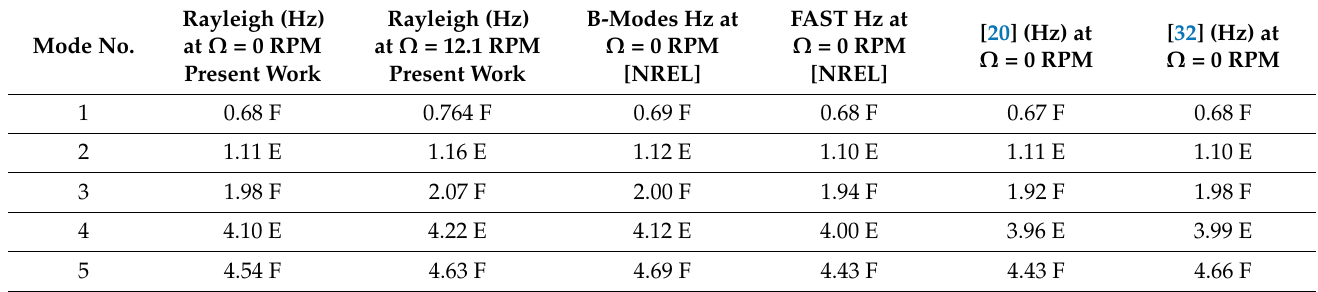
Table 4. Natural frequencies in the flap-wise and edge-wise directions of a single blade without aerodynamic force at angular speed Ω = 12.1 RPM for the present study and Ω = 0 RPM for the present study and for the data adapted from [13,20,32] (F = Flap, E = Edge).